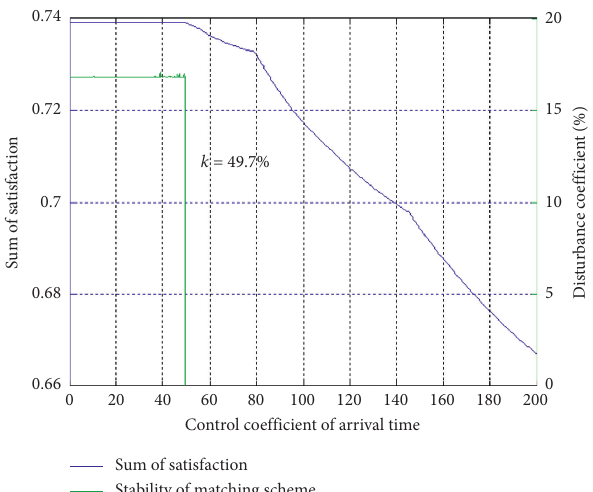
Figure 4: Relationship between κ and the satisfaction of schemes, and the relationship between κ and stability of the κ -current